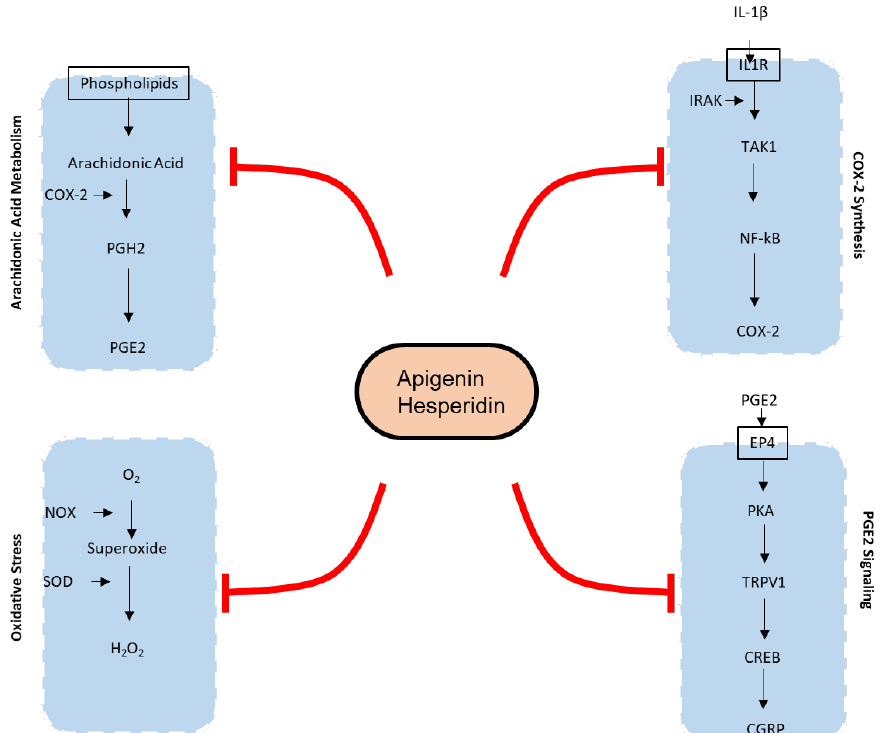
Figure 2. Mechanisms of action of joint pain affected by apigenin and hesperidin. Oval with black outline contains the bioactive molecules. Apigenin and hesperidin affect five biomarkers of